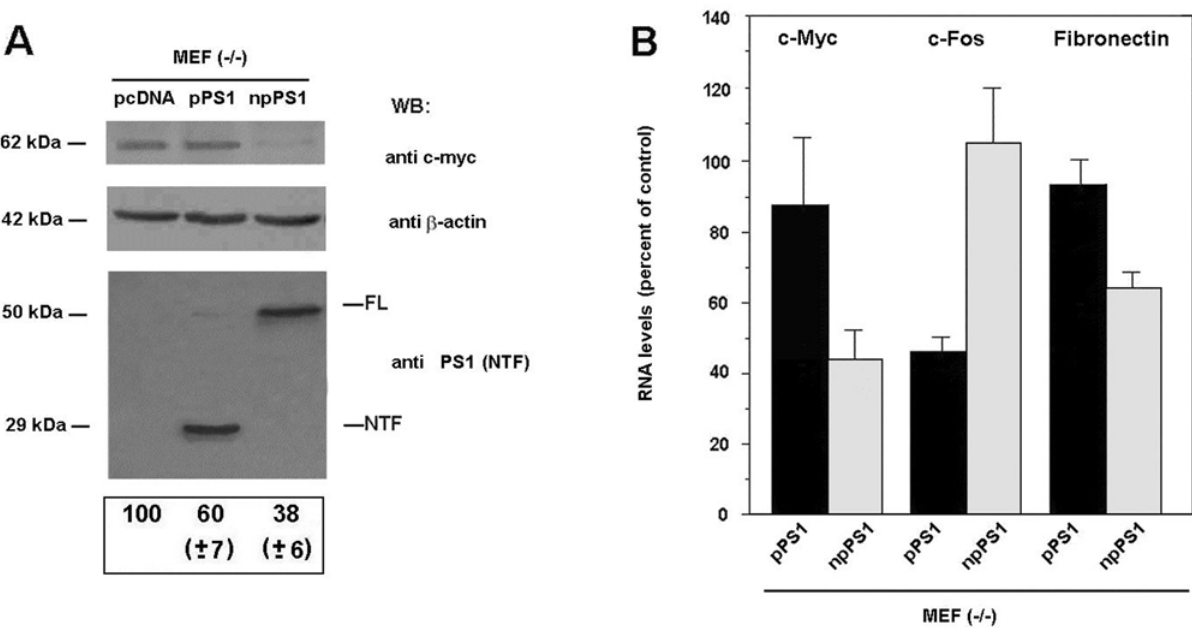
Figure 9. pPS1 and npPS distinctly affect the expression of b -catenin ? Tcf-4-dependent transcriptional targets. MEF PS ( 2 / 2 ) cells were cotransfected with 10.5 m g of either pcDNA3.1-PS1 (pPS1), pcDNA3.1- Myc/His- PS1 (npPS1) or empty vector and 1.5 m g pBABE-puro hrGFP. After 48 h, transfected cells were selected with 2.5 m g/ml Puromycin for 48 h and protein extracts or RNAs were prepared as described in Material and Methods. (A) 25 m g of total cell extracts were analyzed by SDS-PAGE and Western blot with antibodies against PS1 (1–65), c-myc and b -actin as a control. 10 5 transfected cells were seeded and cell proliferation analyzed by counting the number of cells every 24 h. The reduction in the proliferation rate of pPS1 and npPS1 transfected cells is shown referred to the proliferation rate of cells transfected with the empty vector. (B) RNAs were obtained from the three transfectants populations as reported in Methods and the levels of the indicated transcripts analyzed by quantitative RT-PCR. The panel shows the relative expression of these genes with respect to the control (average + / 2 S.D. of three determinations carried out in triplicate).